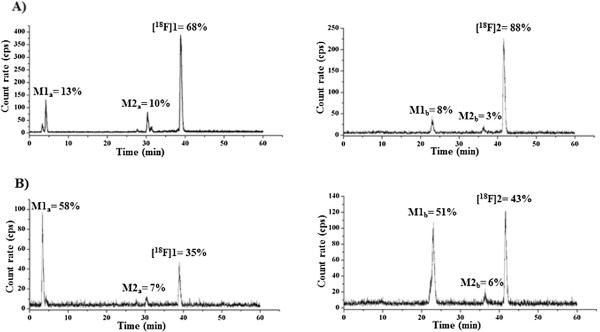
Analytical radio-HPLC profile of acetonitrile extracts of brain homogenates. (A) At 30 min p.i. and (B) 60 min p.i. Conditions: Multospher 120 RP 18 AQ, 5 μm, 250 × 4.6 mm. Solvents: A: 10% MeCN/20 mM NH4OAc, B: 90% MeCN/20 mM NH4OAc. Gradient elution (A%): 0 to 10 min, 100%; 10 to 40 min, gradient from 100% to 0%; 40 to 45 min, 0%; 45 to 50 min, 100% at a flow rate of 1 mL/min.